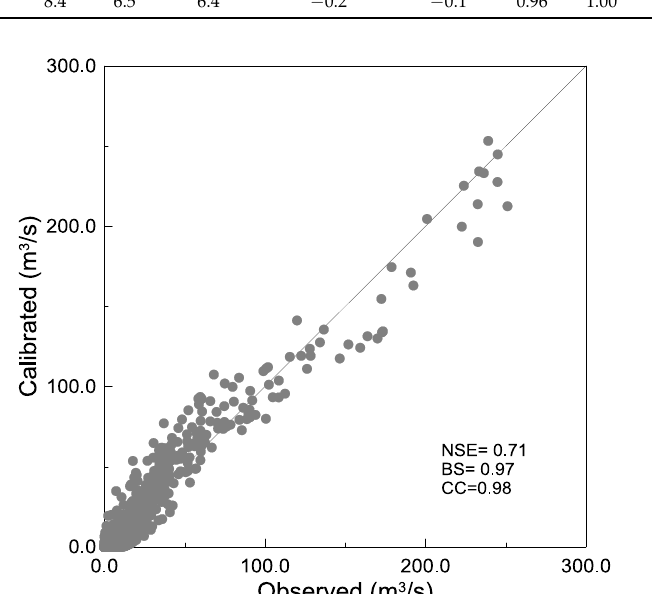
Figure 13. Scatterplot of the observed and calibrated runoff flows for the sixteen storm events in Table 4: In the figure, the acronyms are same as Table 4 and the values are in average. In the application example, a different complex storm event was simulated, which was not used in